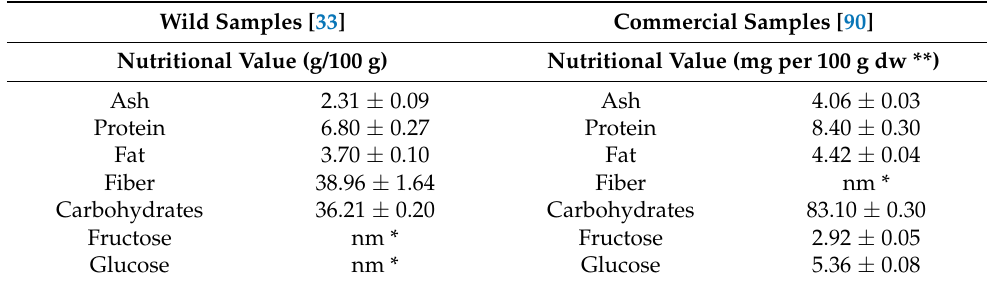
Table 1. Nutritional composition of C. vulgaris flowers: comparison between wild and commercial